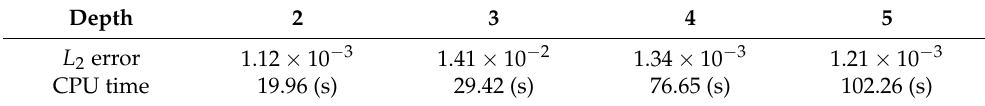
Table 1. Example 1: L 2 error and CPU time using different depths under width = 50 and 2000 training data.